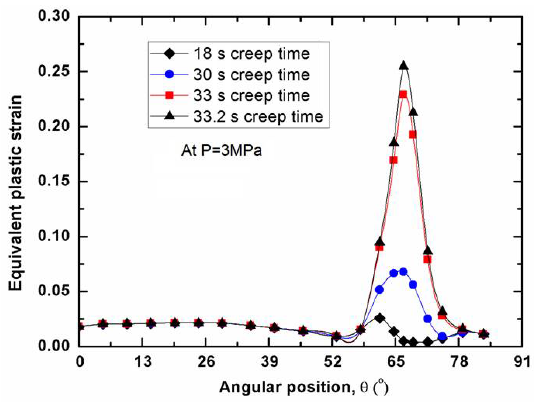
Figure 12. Comparison of creep distributions for RPV with various water levels under P =